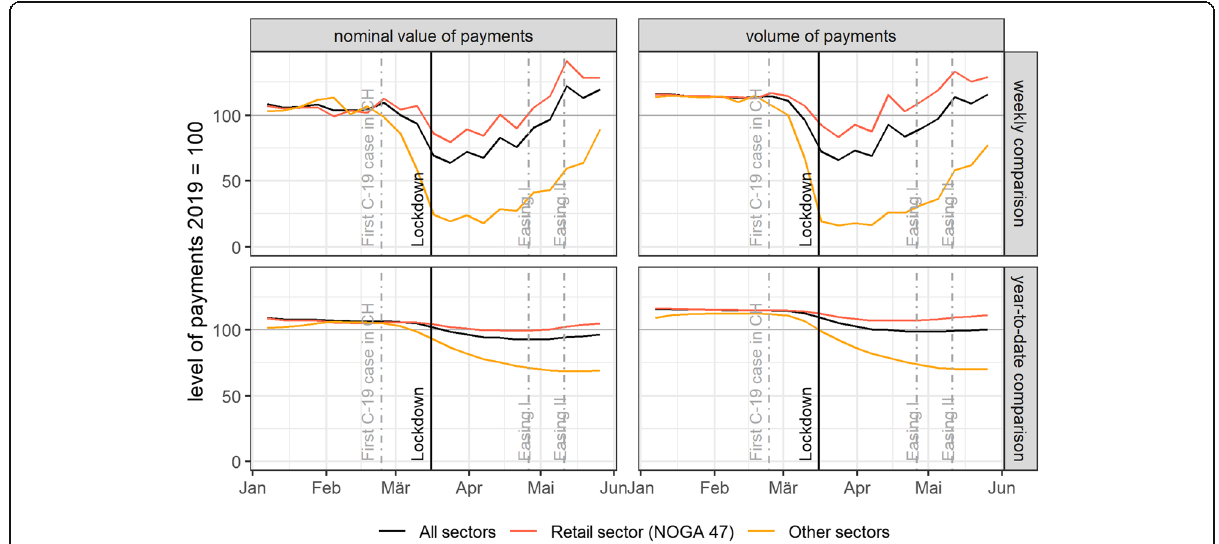
Fig. 1 Card payment activities in Switzerland in 2020. Source: Own calculations, Worldline/SPS